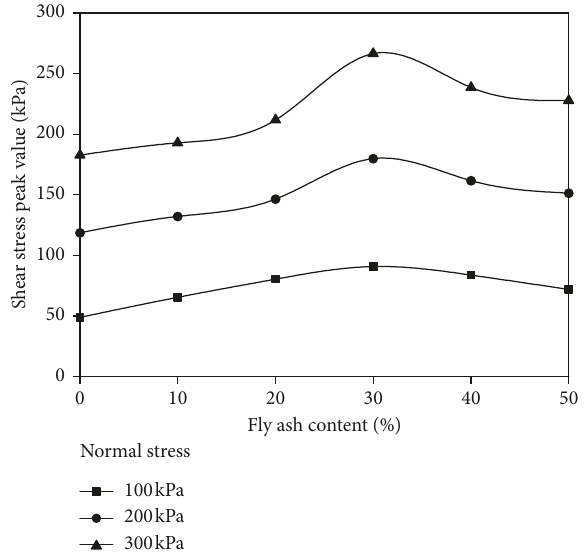
Figure 5: The relationship between shear stress peak value and fly ash content under different normal